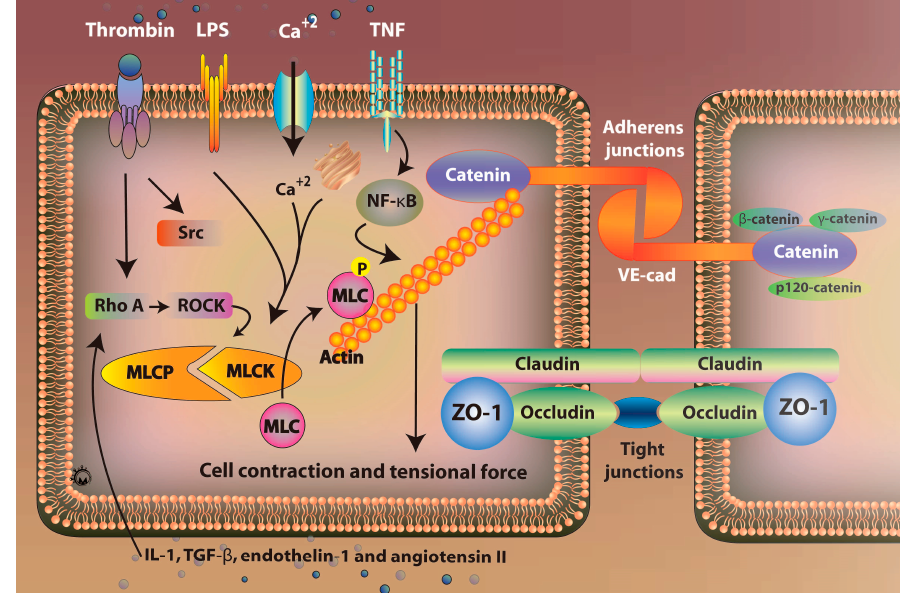
Figure 3. Mechanisms of pulmonary vascular endothelial regulation. Vascular permeability was regulated via actin-myosin interaction. The barrier disruption and enhancement was mediated by the phosphorylation of myosin light chain (MLC) regulated by myosin light chain kinase (MLCK) and myosin light chain phosphatase (MLCP). Activation of the actin myosin increases stress fi ber formation and cause in cell contraction and tensional force to adherens junction (AJ). Rho/ROCK signaling can be activated by thrombin, IL-1, TGF- β , endothelin-1 and angiotensin II. Activation of RhoA induced ROCK to activate MLCK, causing to enhance vascular permeability. The MLCK also is activated by Ca 2+ from endoplasmic reticulum or extracellular space. The TNF and Ca 2+ may induced expression of nuclear factor κ B (NF- κ B) causing to degrade the endothelial glycocalyx. The Src signaling mediated VE-cadherin phosphorylation leading to VE-cadherin internalization by activation of thrombin.